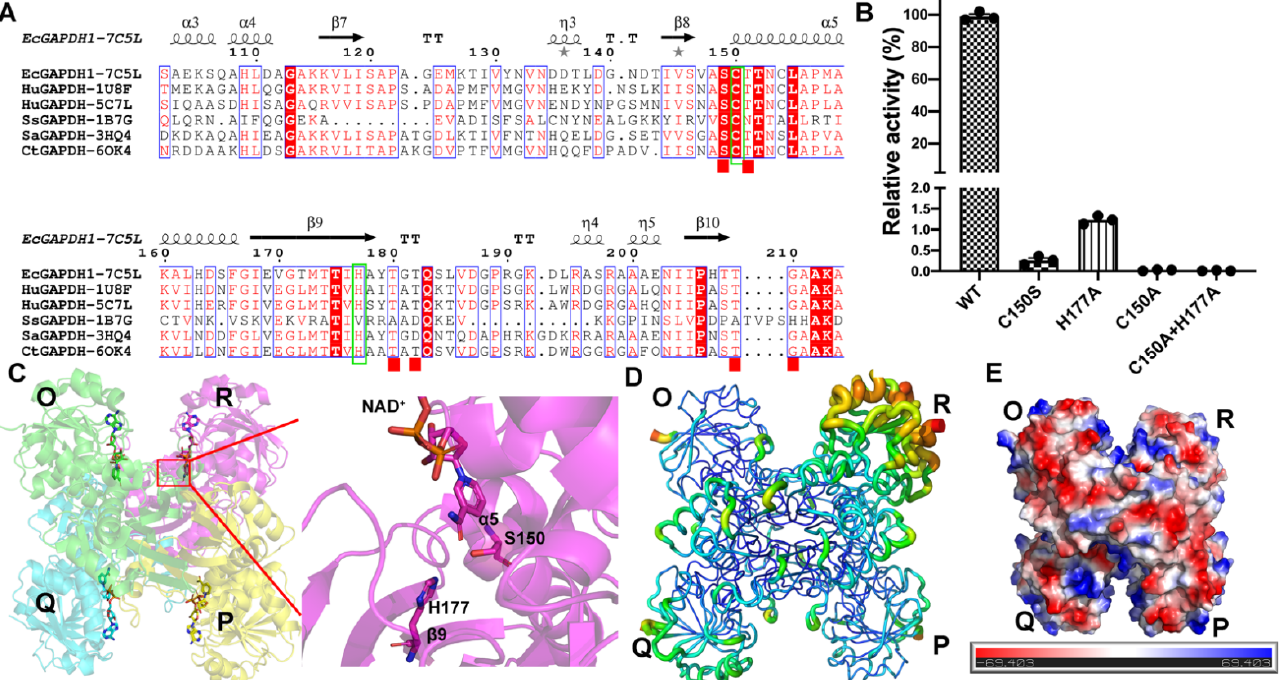
Figure 1. Overall structural and enzyme characteristics of mutants of Ec GAPDH1. ( A ) Structural-based alignment of GAPDH from archaea Saccharolobus solfataricus (PDB code: 1B7G, Ss GAPDH) [18] and bacteria Chlamydia trachomatis (PDB code: 6OK4, Ct GAPDH) [36], Staphylococcus aureus MRSA252 SaGAPDH (PDB code: 3HQ4, Sa GAPDH), and GAPDH from human placenta (1U8F) [37] and testis (5C7L) [38]. Amino acids that participate in the enzyme catalytic process are presented in the green box. Secondary structure elements included C150S.NAD (7C5L) and wild-type sequences were used for structural alignment. ( B ) Mutant Ec GAPDH1 enzyme characteristics. ( C ) Overall structure of C150S.NAD (7C5L). ( D ) The B-factor distribution of C150S.NAD (7C5L). Wider and redder tubing indicates a higher B-factor. ( E ) The structure of the C150S.NAD (7C5L) surface electrostatic potential. Blue represents a positive potential and red depicts a negative potential.